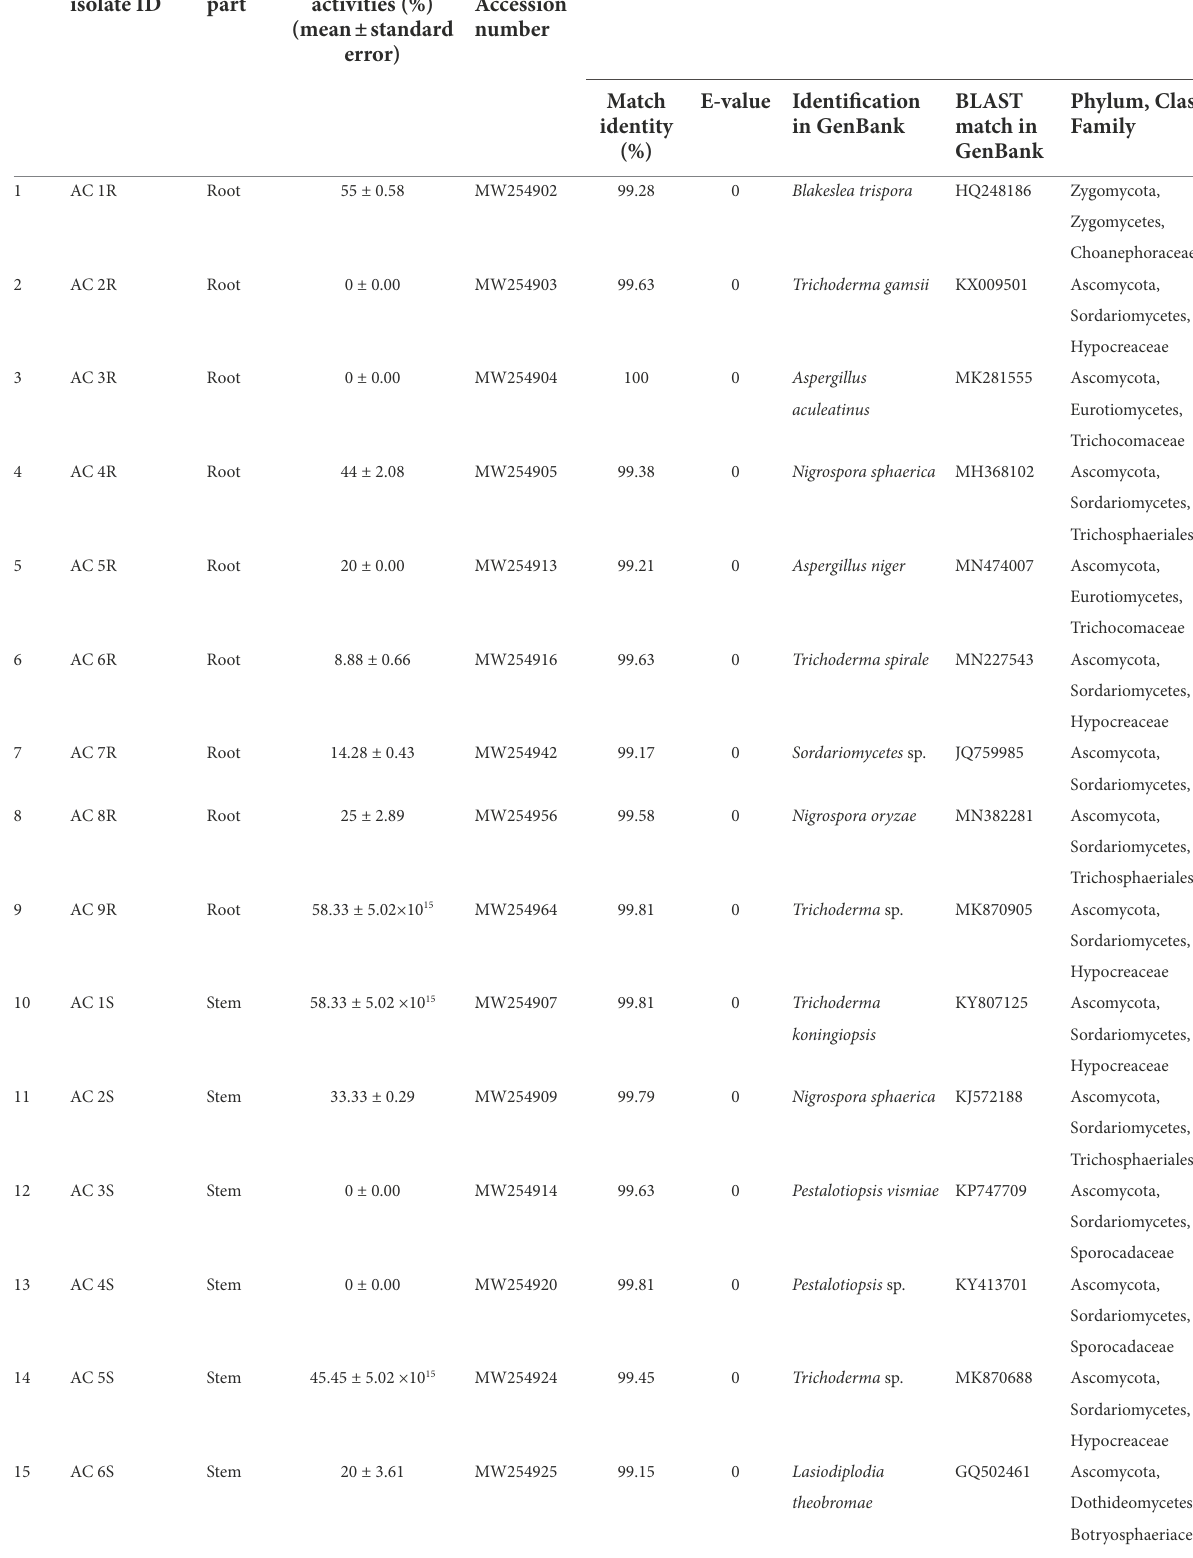
TABLE 2 Percentage of identity matches of 66 fungal isolates from different plant parts of Acacia mangium based on ITS sequences using BLAST analyses, and their percentage of inhibition against Ceratocystis fimbriata . No. Endophytic isolate